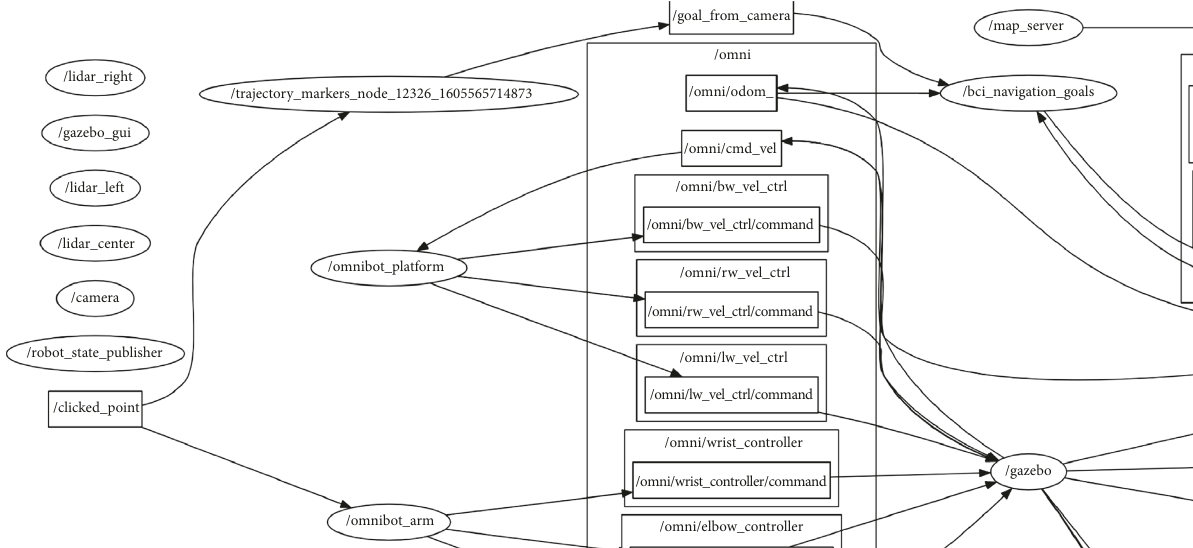
Figure 13: Partial control block diagram for an assistive robot